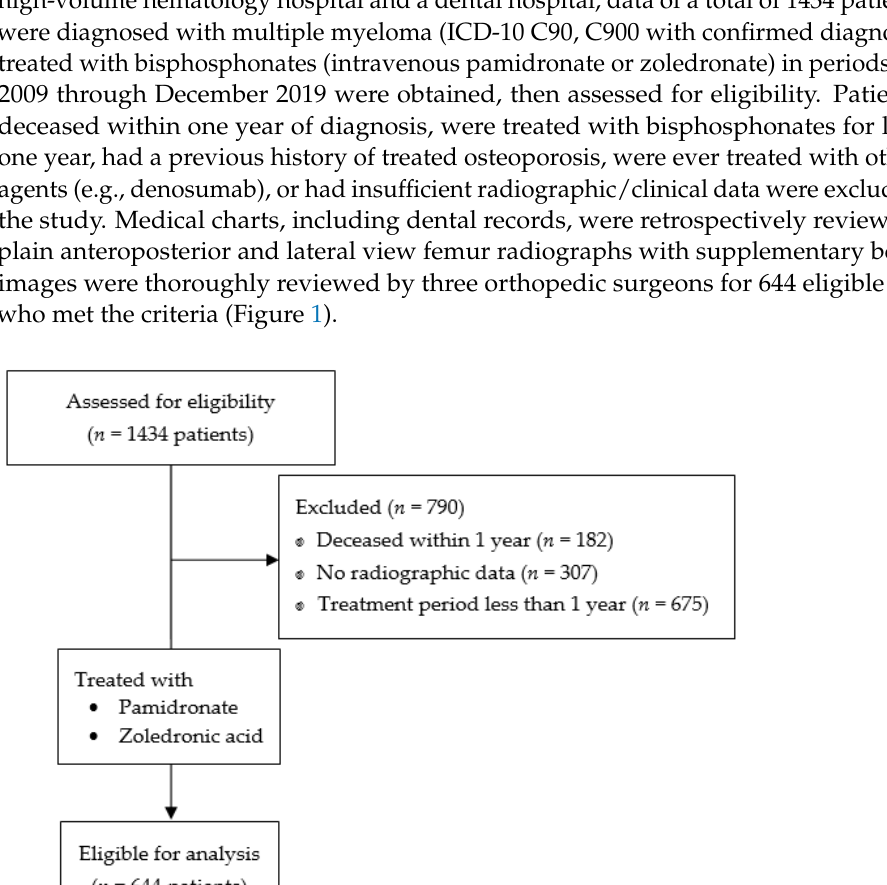
Figure 1. Flow dia- gram for the deter- mination of the study population for assessment. The Ameri- can Society for Bone and Mineral Research (AS- BMR) task force 2013 revised defi- nition of AFF [22] was used to evalu- ate the presence of AFFs or incom- plete AFFs. The